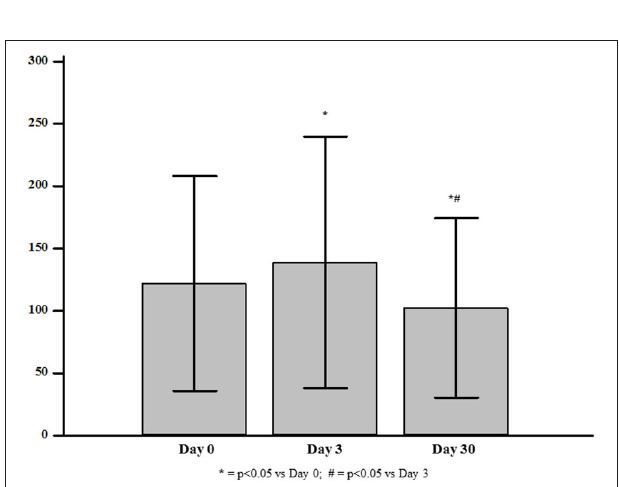
FIGURE 4 | Levels of Vascular Endothelial Growth Factor (VEGF) at baseline and at day-3 and day-30 after zoledronic acid administration.